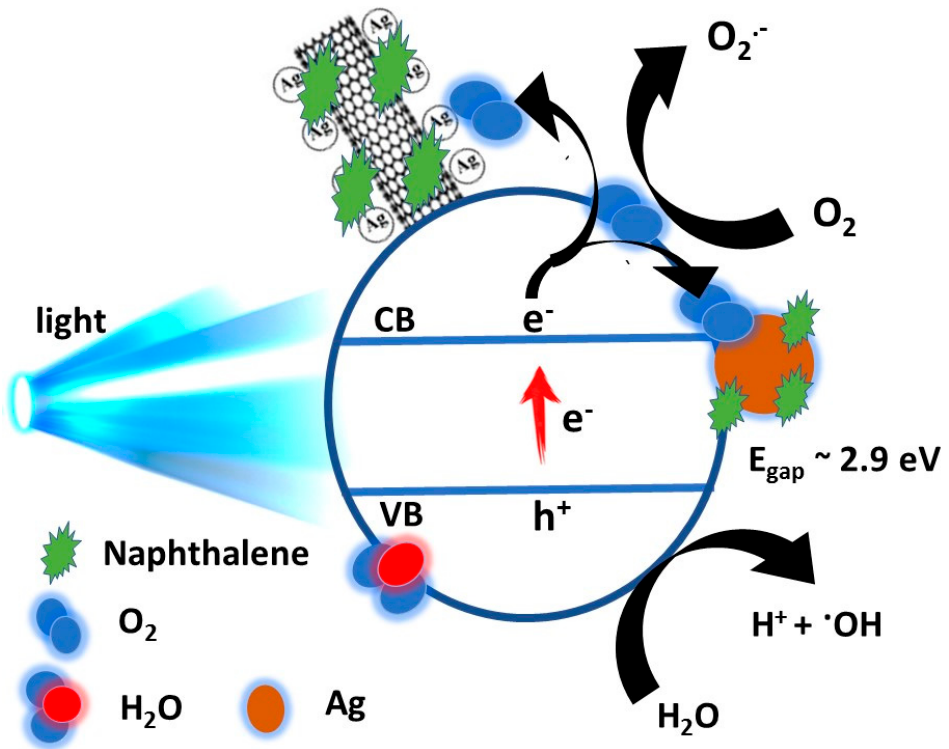
Figure 11. Schematic diagram of the photocatalytic degradation of naphthalene by Ag NPs/CNT.